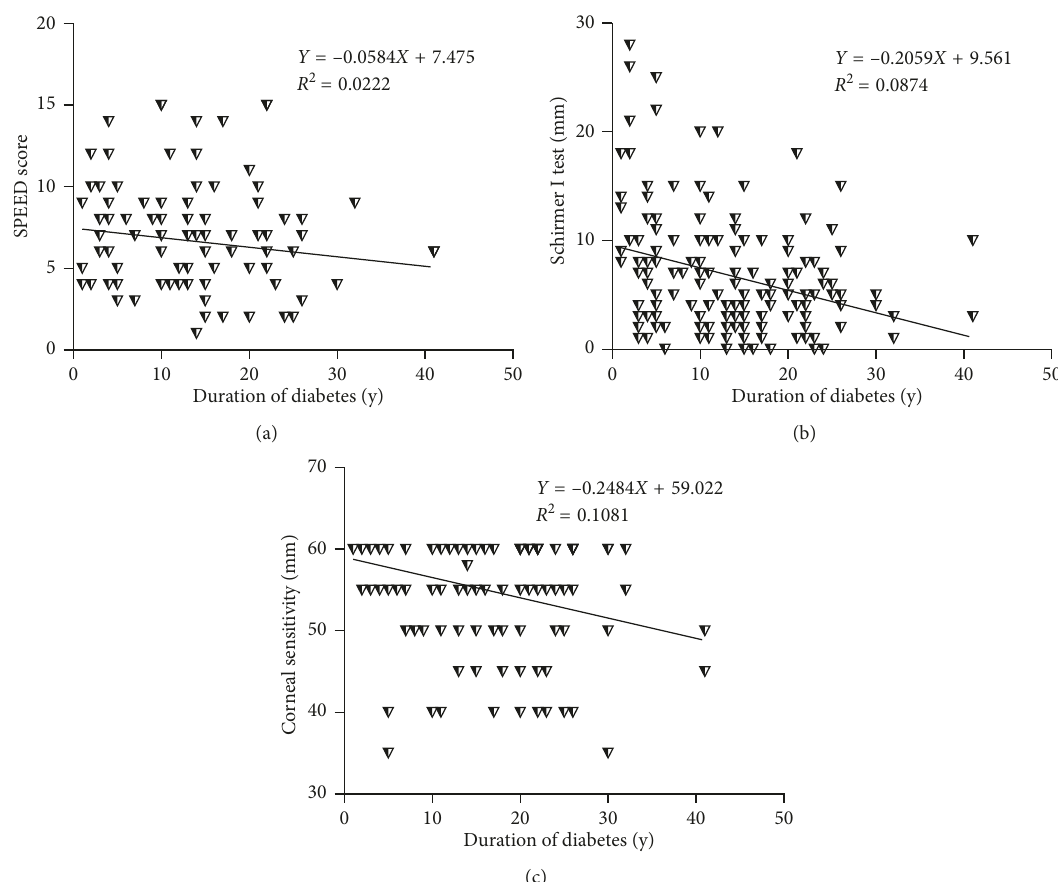
Figure 4: Correlations between ocular surface parameters and duration of diabetes. In the total diabetic group, the SPEED score (a), Schirmer I test (b), and corneal sensitivity (c) were negatively correlated with duration of